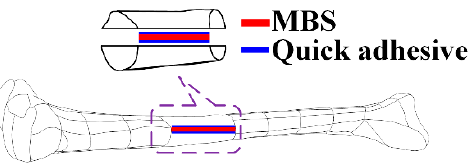
Figure 2. Model of the embedded magnesium-based artificial bone (EMBAB). MBS: magnetoelastic-based sensor.